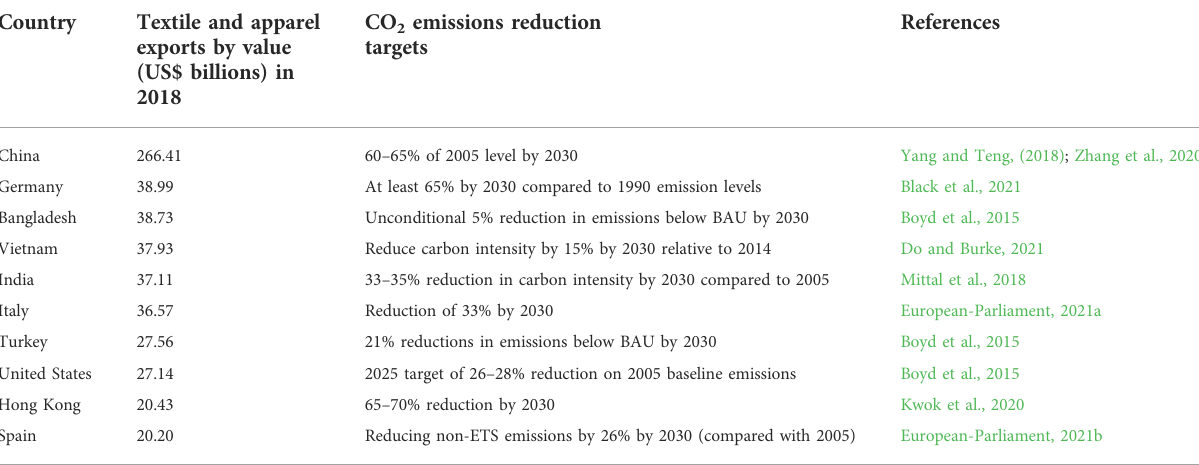
TABLE 2 CO 2 emissions reduction targets of the top 10 textile and apparel exporting countries. CO 2 emissions reduction Country Textile and apparel exports by value (US$ billions) in 2018